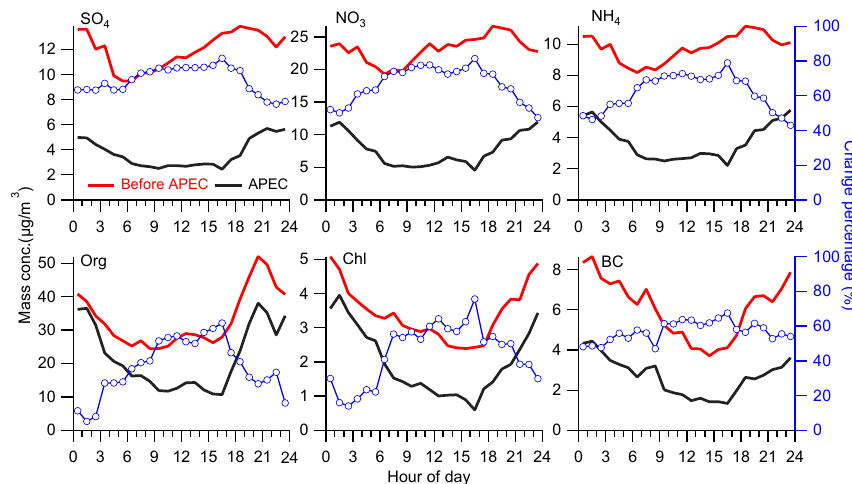
Figure 2. Diurnal profiles of the mass concentrations of PM 1 species measured before and during the Asia-Pacific Economic Cooperation (APEC) summit. Also shown are the changes in percentage of aerosol species occurring during APEC.